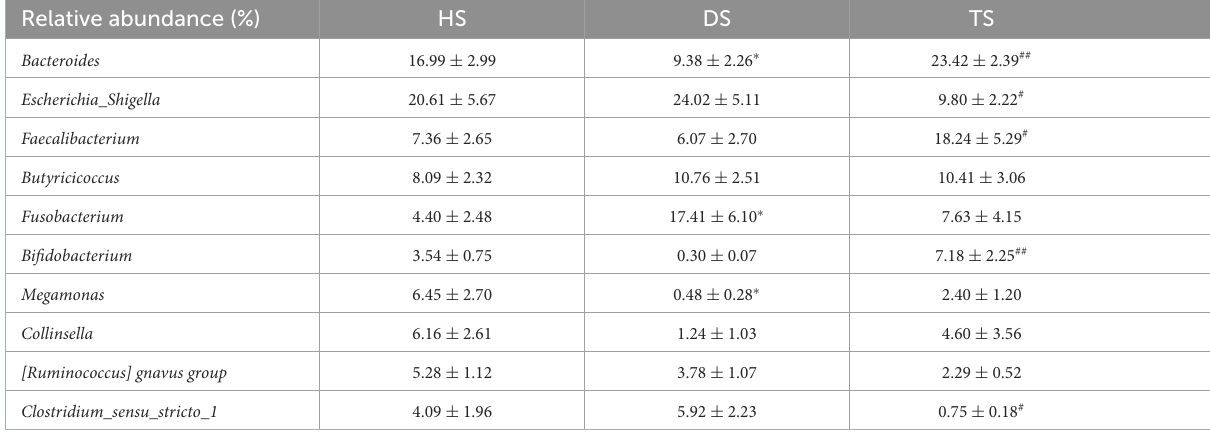
TABLE 1 The relative abundance of top 10 genera during the PLP treatment. Relative abundance